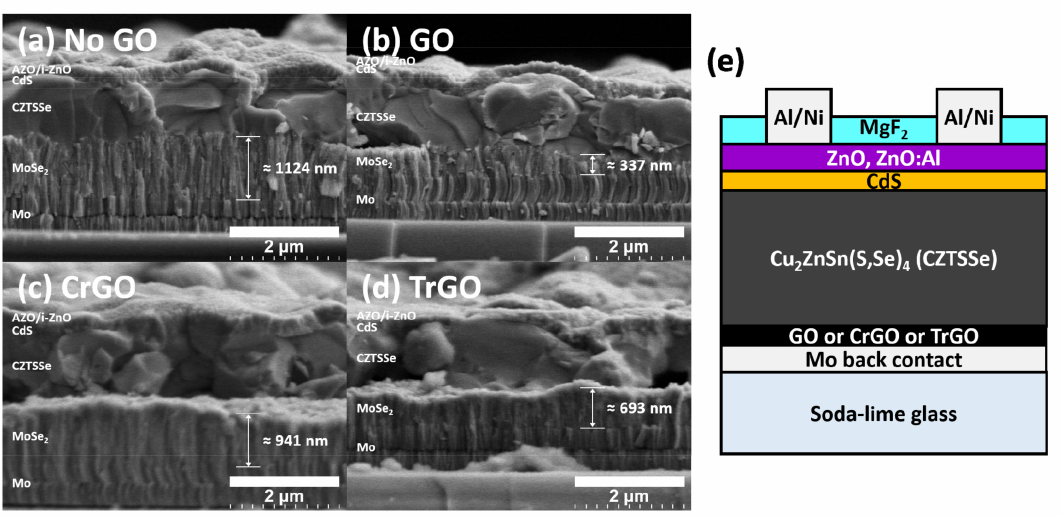
Figure 5. ( a – d ) Cross-sectional SEM images and ( e ) schematic of the CZTSSe solar cells fabricated with different graphene oxide intermediate layers.